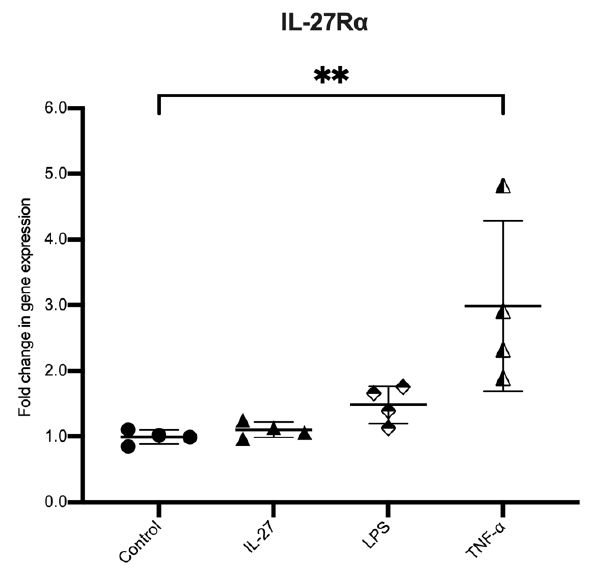
Figure 6. Expression of IL-27R α in human colonic organoid in a model of IBD. Expression of IL-27R α in human colonic organoids stimulated with rhIL-27 (100 ng/mL), LPS (500 ng/mL) and TNF- α (100 ng/mL) compared to unstimulated controls. Gene expression normalised to GAPDH; n = 3 individual patient-derived organoids stimulated in triplicate for each stimulation, presented as mean ± SD. Statistical analysis with Kruskal–Wallis test. * p < 0.05, ** p < 0.01, *** p < 0.001 and **** p < 0.0001; ns = not significant.